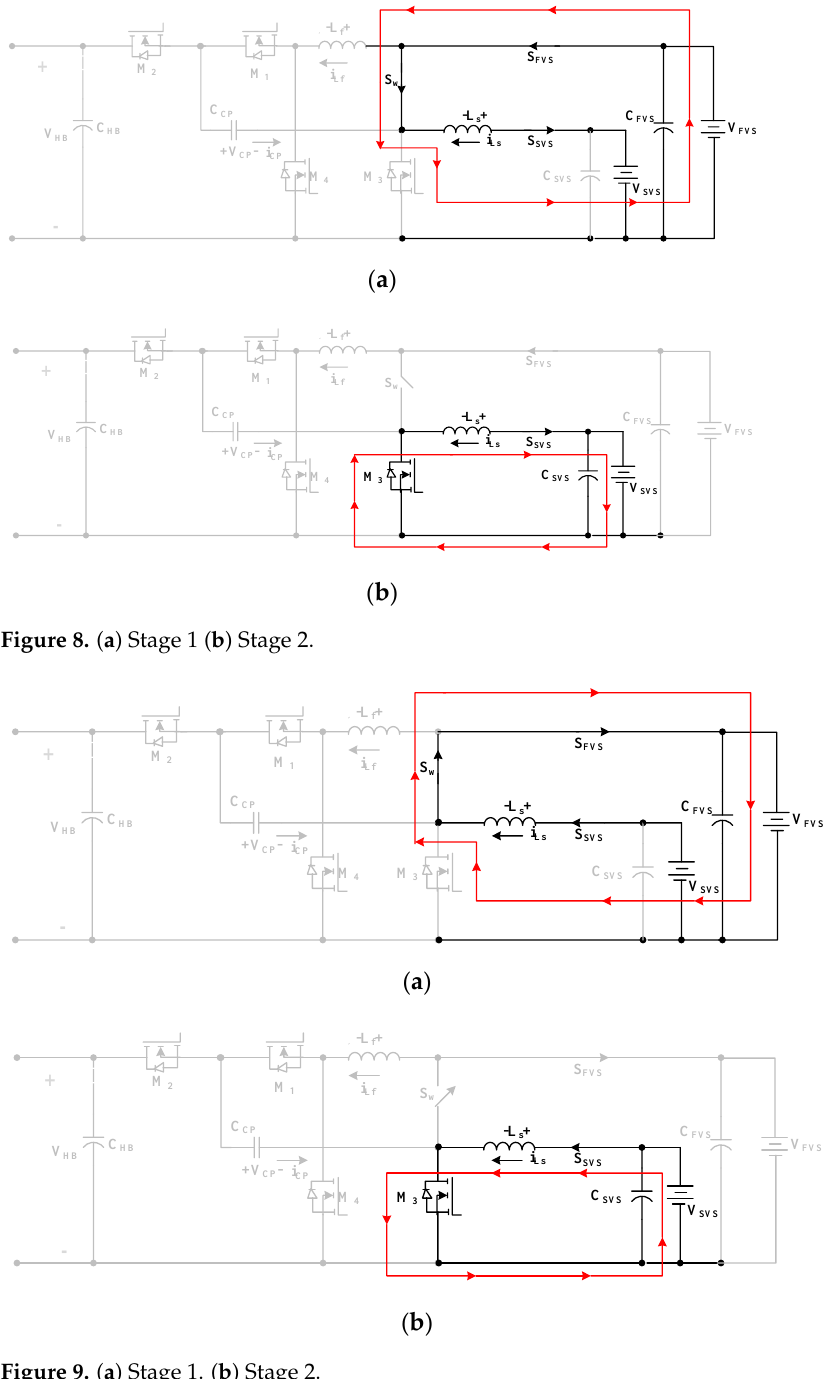
Figure 9. ( a ) Stage 1. ( b ) Stage 2.